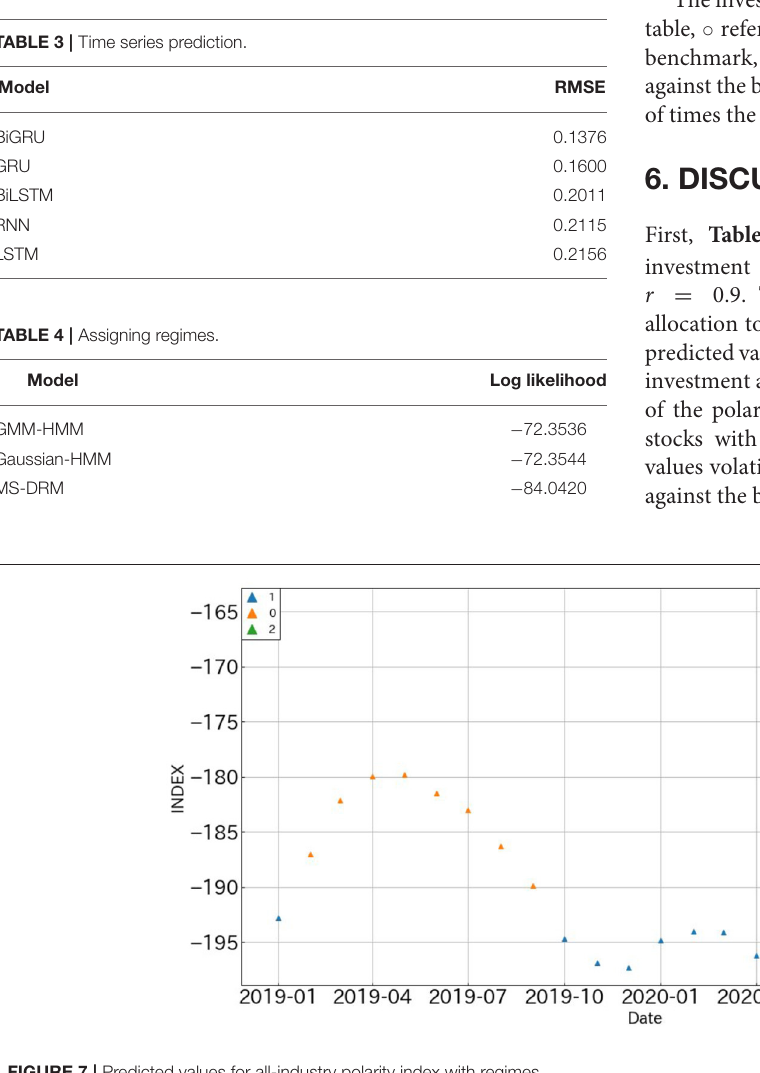
FIGURE 7 | Predicted values for all-industry polarity index with